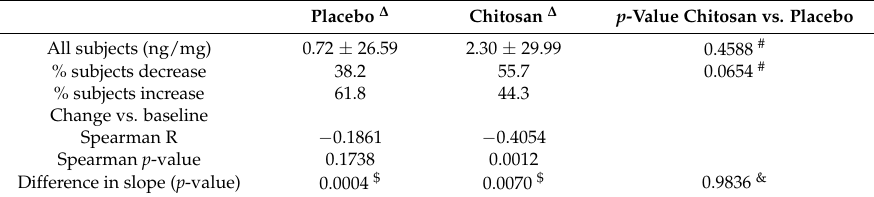
Table 11. Comparison of changes in serum total R_lanosterol induced by chitosan and placebo treatments. Placebo